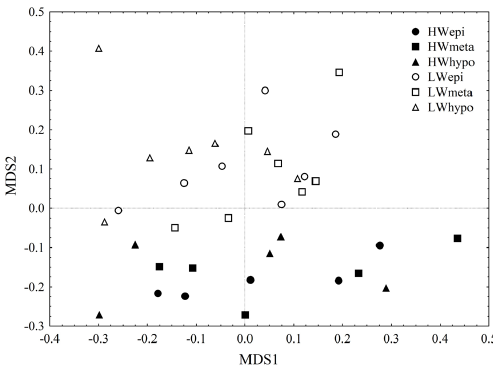
Figure 10. Multi-dimensional scaling (MDS) plot based on Jaccard distances in three different strata in two hydrological periods (HWepi = epilimnion during high waters; HWmeta = metalimnion during high waters; HWhypo = hypolimnion during high waters; LWepi = epilimnion during low waters; LWmeta = metalimnion during low waters; LWhypo = hypolimnion during low